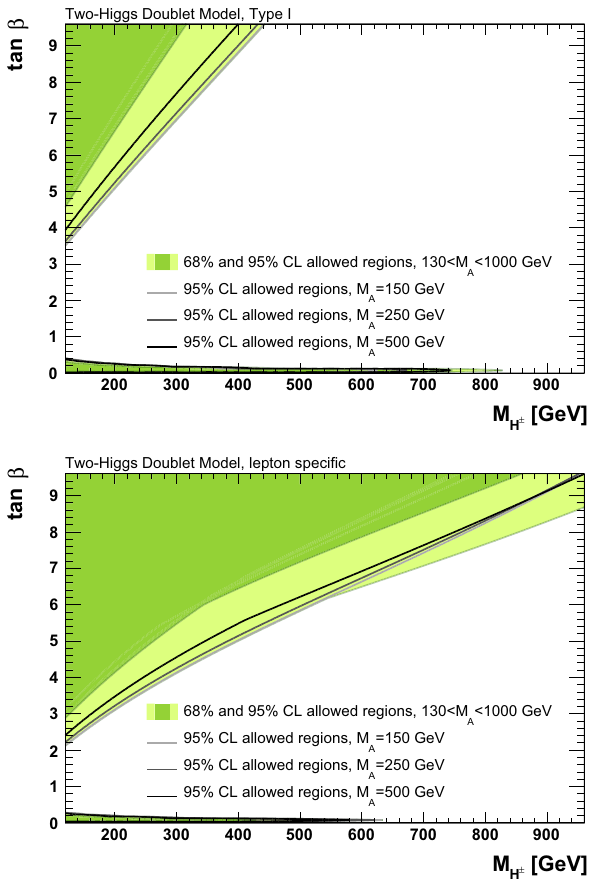
Fig. 10 2HDMfitsusingtheanomalousmagneticmomentofthemuon as input. The green areas show allowed 68 and 95% CL regions in the tan β versus M H ± plane for freely floating M A and the four 2HDM sce-